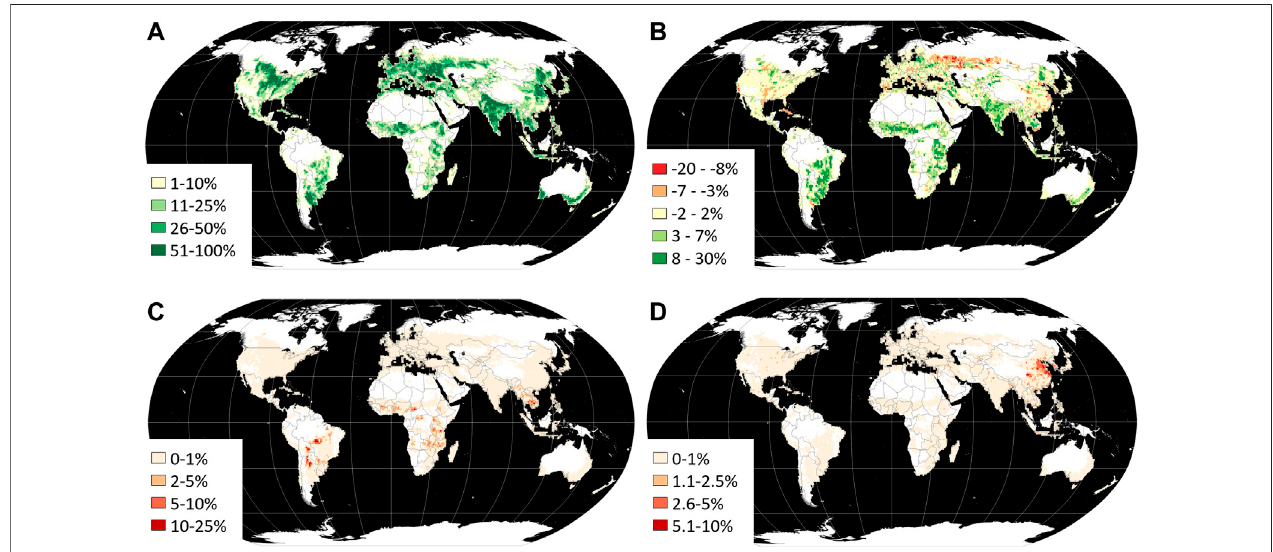
FIGURE4| Croplandextentanddynamicsforeach1×1 ° gridcell. (A) Croplandarea2019,%cellarea. (B) Netcroplandareachange,2000 – 2019,%cellarea. (C) Cropland gain 2000 – 2019 within forest loss 2000 – 2020 area, % cropland gain area within a cell. (D) . Cropland loss 2000 – 2019 within the year 2020 built-up lands, % cropland loss area within a